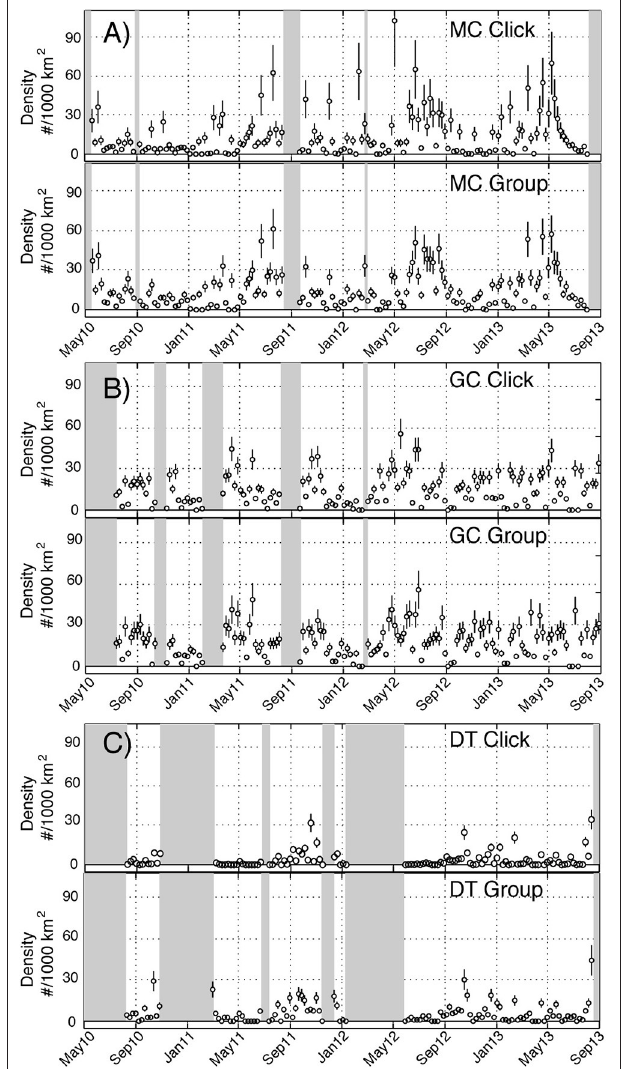
FIGURE 9 | Time series of weekly density estimates for Kogia spp. between May 2010 and September 2013 at sites MC (A) , GC (B) , and DT (C) based on click counting (above) and group counting (below). Circles denote estimates and vertical lines show ± one standard error. Shaded areas lack recording effort.